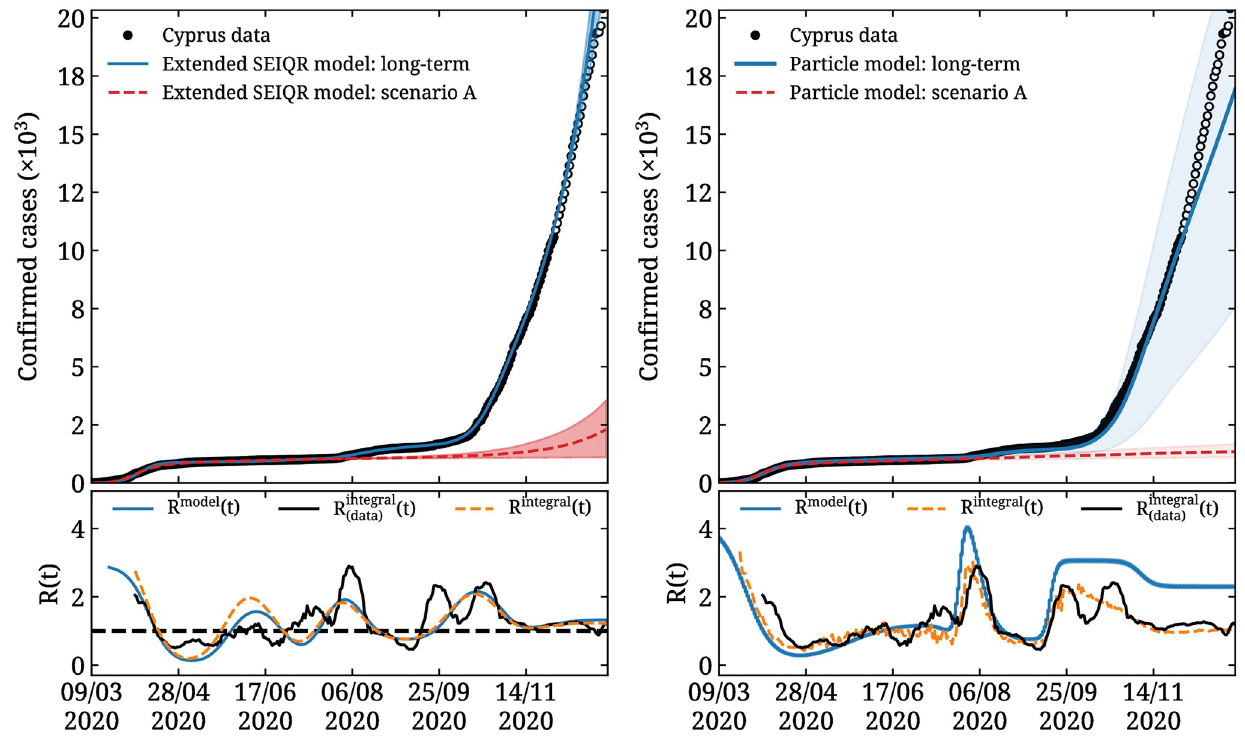
Fig 8. Modeling of longer time series. The SEIQR model (left) and the particle model (right) fitted to the Cyprus cumulative confirmed cases up to November 30 th (solid blue curve and band) as explained in the addendum and compared to scenario A (dashed red curve and band). The filled black circles are the Cyprus confirmed cases included in the fit, while the open black circles are not included in the fit. The forecast is for one month, assuming the infection rate stays constant . In the lower panels we show the effective reproduction number as obtained by applying Eq (16) to the Cyprus confirmed cases denoted as R integral ð t Þ (black curve), in addition to R model ( t ) (blue curve) and R integral ( t ) (orange dashed ð data Þ